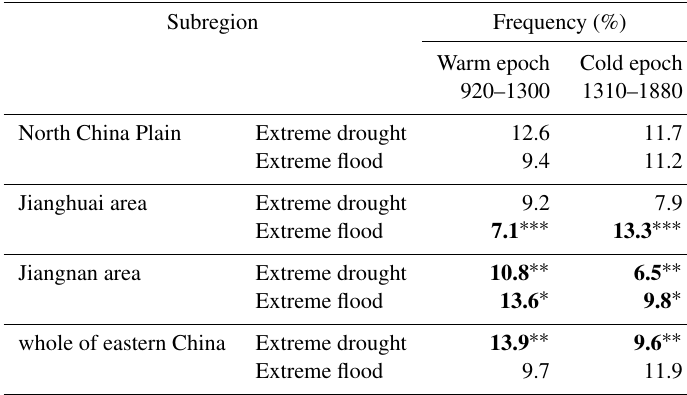
Extreme drought Years Extreme flood Years Extreme